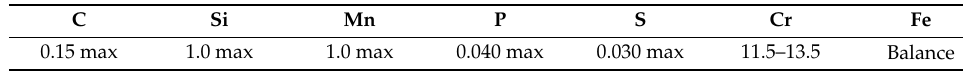
Table 1. Chemical composition of AMS 5504 steel (%wt.) [29].